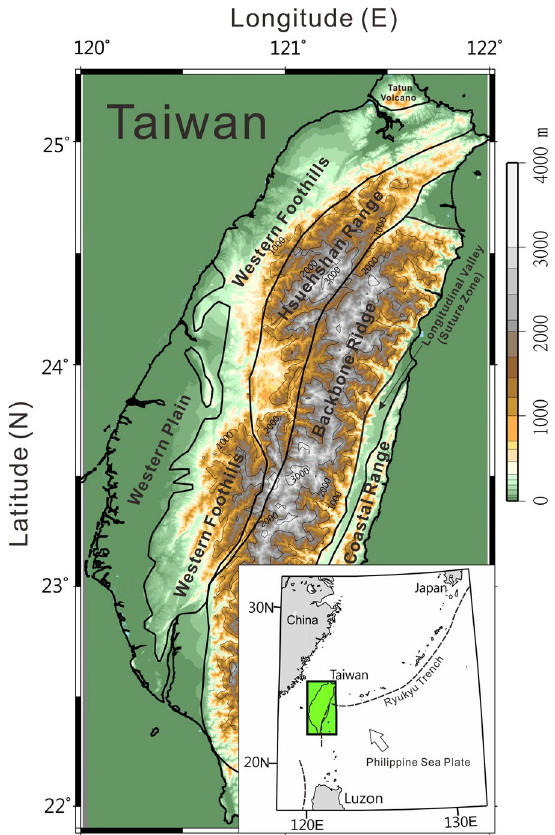
Fig. 1 Geologic provinces and topographic reliefs in Taiwan. The insert map shows general tectonics in and around